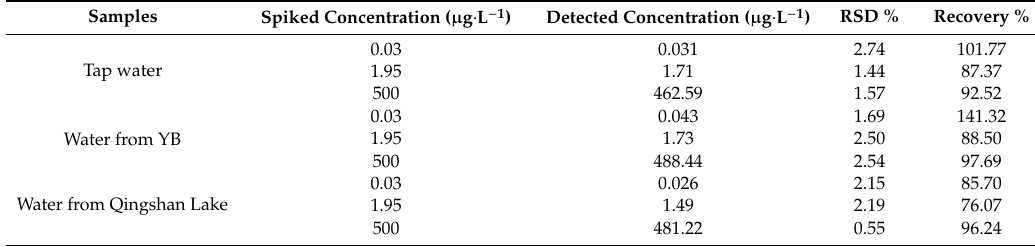
Table 3. Recovery results of DEHP added in di ff erent water samples with the